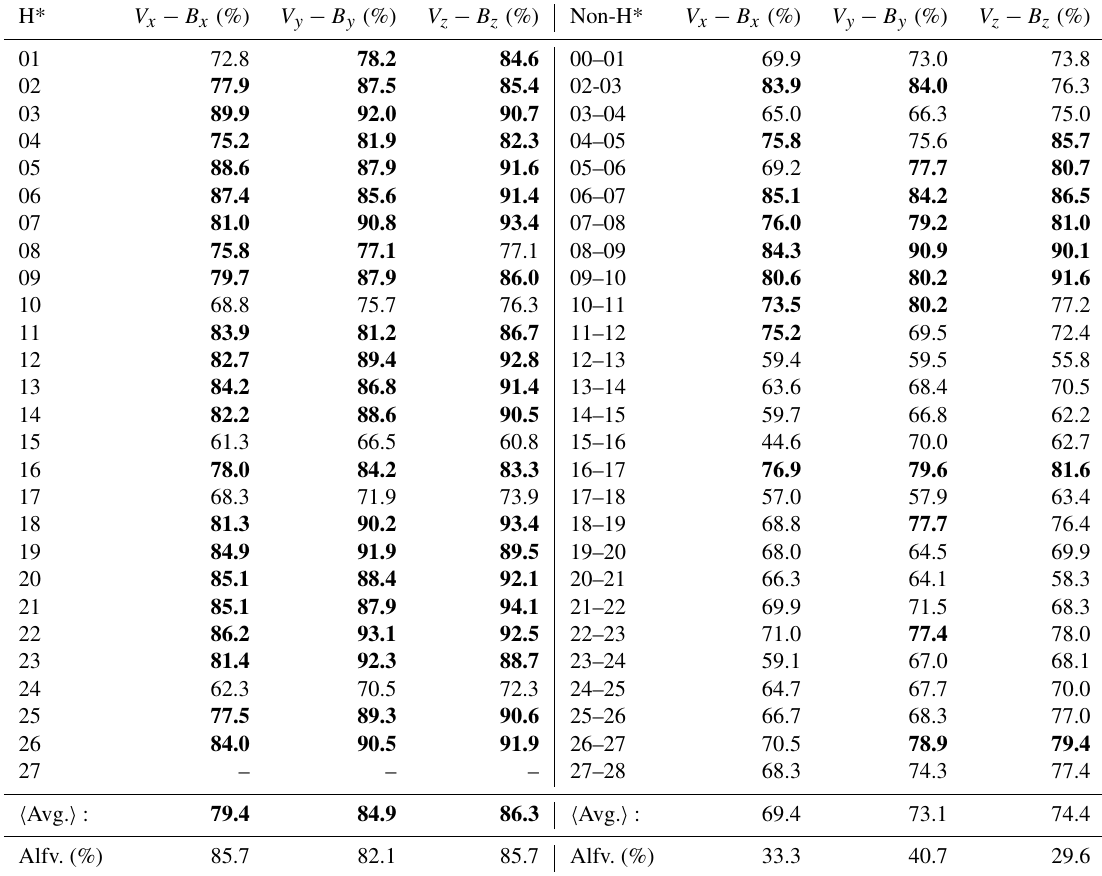
Table 2. HILDCAA* events for the year 2003. The HILDCAA* events with 4WPCC higher than the 4WPCC annual average are highlighted in